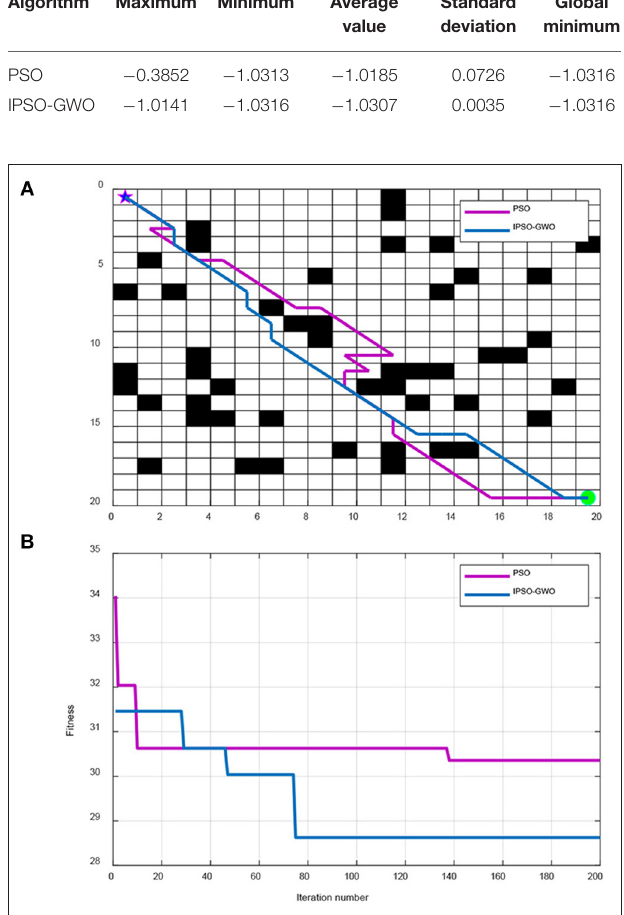
FIGURE 4 | Simulation results of IPSO-GWO and PSO in 20 × 20 map environment. (A) Path comparison with PSO and IPSO-GWO algorithms. (B) Iterative curves with PSO and IPSO-GWO algorithms.